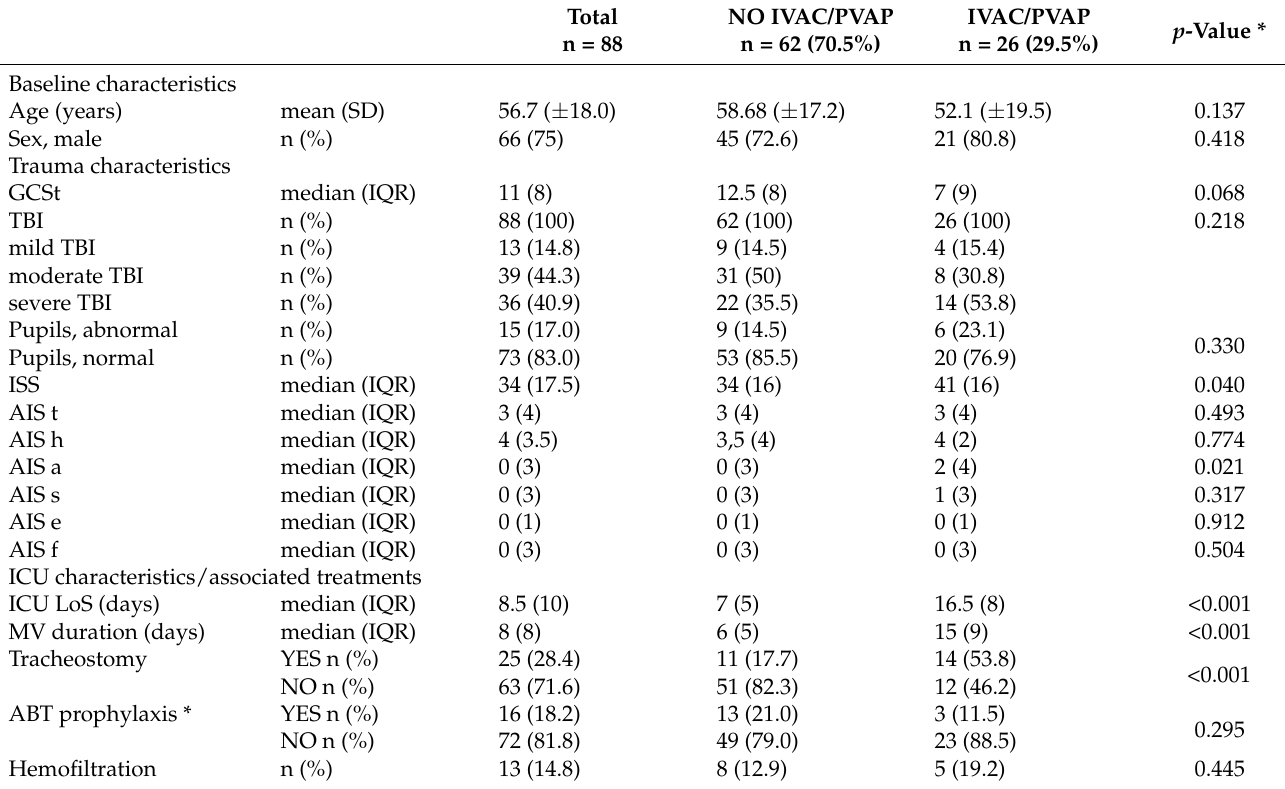
Table 1. Baseline patient characteristics, trauma-associated injury severity, and ICU LoS/associated treatments of the overall population and stratified according to IVAC/PVAP status. IVAC: infection- related ventilator-associated complications; PVAP: possible ventilator-associated pneumonia; SD: standard deviation; IQR: interquartile range; BMI: body mass index; GCSt: Glasgow coma scale (total score); TBI: traumatic brain injury; ISS: injury severity score; AIS: abbreviated injury scale; c: chest;